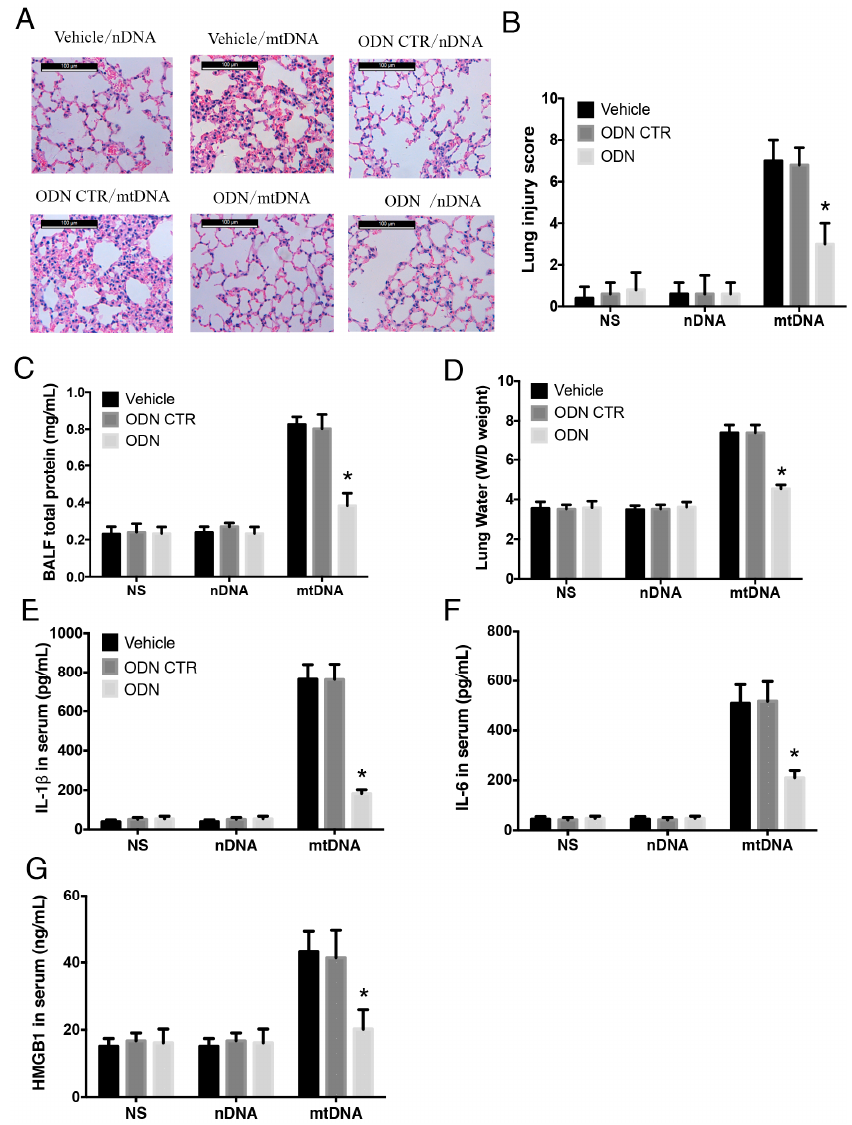
Figure 5. Intra-peritoneal administration of mtDNA induces acute lung injury and systemic inflammation in a TLR9-dependent manner. WT mice were randomly assigned to a group pretreated with the TLR9 specific inhibitor ODN2088 or a control group. Mice in the ODN2088 were pretreated 1 h before mtDNA administration ( n = 16/group, 8 for BALF only). Acute lung injury was measured by HE staining (scale bar is 100 μ m) ( A ) for lung injury score ( B ); BALF total protein concentration ( C ); and lung W/D ratio ( D ) were also analyzed. Systemic inflammation and circulating levels of IL-1 β ( E ); IL-6 ( F ); and HMGB1 ( G ) were measured by ELISA. * p < 0.05 versus control group. Eight mice were used in each set and data are mean ± SEM of three separate experiments.